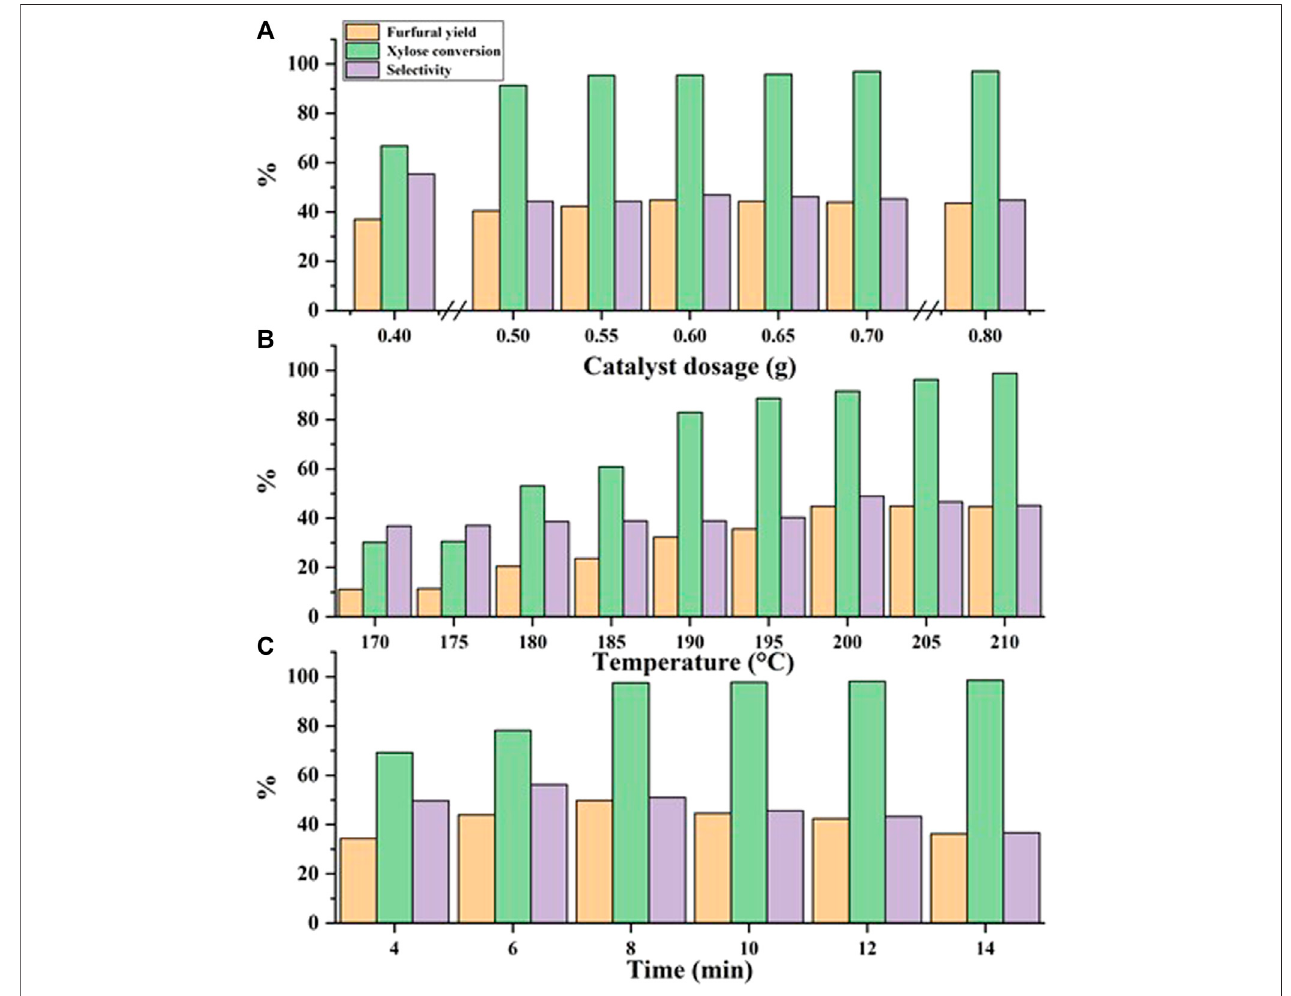
FIGURE5| Experimentalresultsofoptimizedreactionconditions.Reactionconditions: (A) xylose(60 g/L),200 ° C,10 min; (B) xylose(60 g/L),0.6 gC 1 MF,10 min; (C) xylose (60 g/L), 0.6 g C 1 MF, 205 ° C.